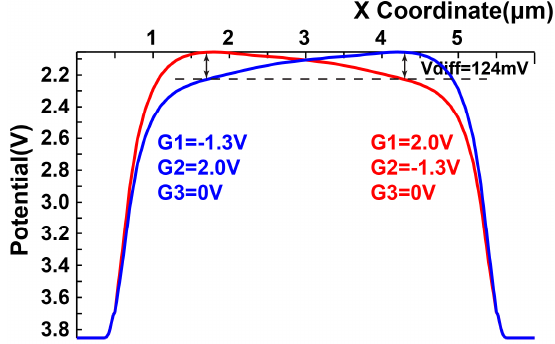
Figure 6. Simulation result of potential profile along X coordinate.